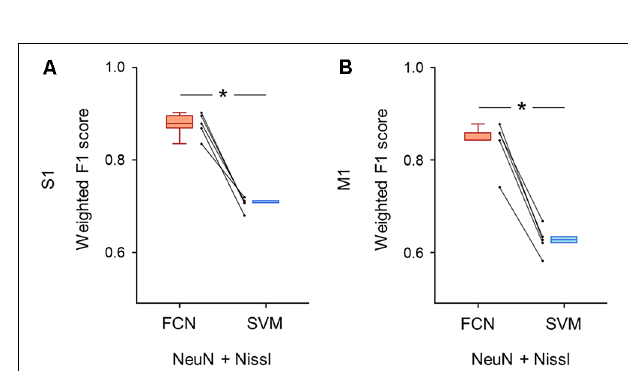
FIGURE 5 | Classification performance of cell images using triple fluorescent signals. (A) Weighted F1 score of the FCN model (red) and the PCA-SVM classifier (blue) trained on cell images from S1. All three fluorescent signals (i.e., anti-GAD67, anti-NeuN, and Nissl) were used for training. Each point (gray) signifies the score for the cross-validation (5-fold). P = 1.3 × 10 –4 , t (4) = 14.7, n = 5-fold cross-validations, paired t -test. * P < 0.05. (B) The same as (A) , but for M1. P = 1.4 × 10 –5 , t (4) = 25.6, n = 5-fold cross-validations, paired t -test. * P < 0.05. Abbreviations: S1, primary somatosensory cortex; M1, primary motor cortex; FCN, fully convolutional network; SVM, support vector machine; PCA, principal component analysis.